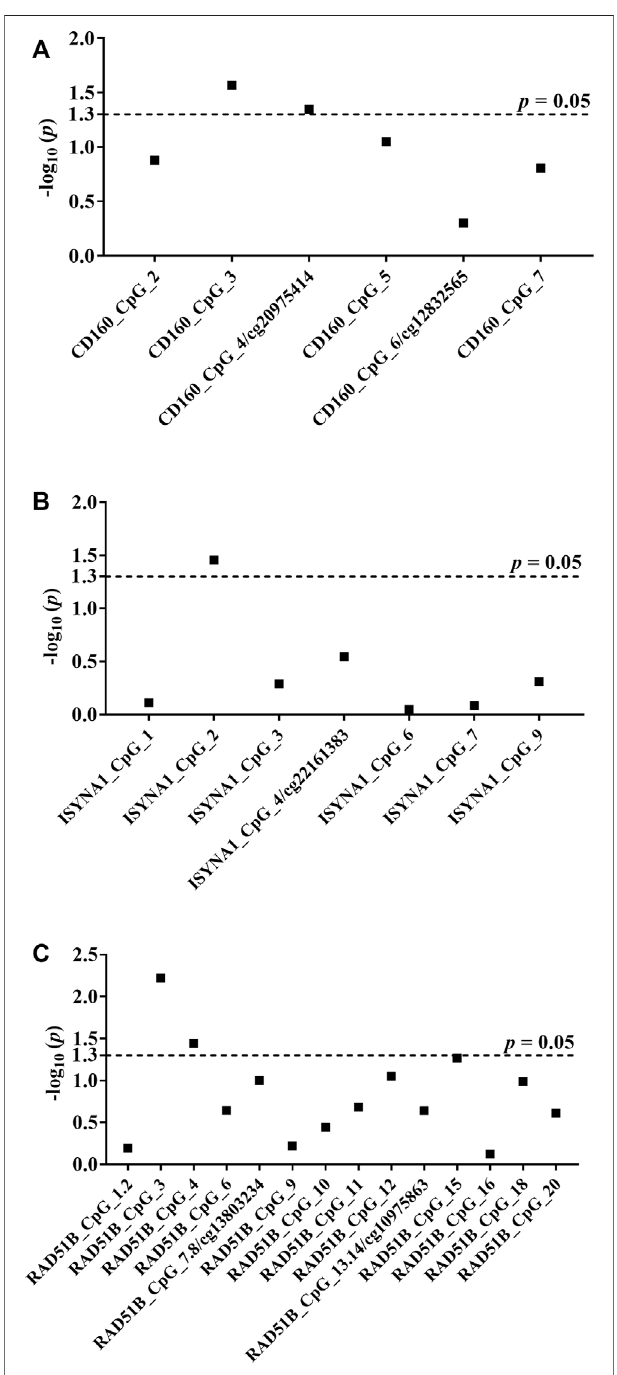
FIGURE 2 | Association between hypomethylation of CD160 , ISYNA1 , and RAD51B and sporadic BC combining validation I and validation II. The p values of all measureable CpG loci were calculated by logistic regression adjusted for age and different batches for the measurements, and all the p values were transformed by − log 10 . The dotted lines indicate the thresholds of p values of 0.05. (A) Association between hypomethylation of CD160 and sporadic BC combining validation I and validation II. (B) Association between hypomethylation of ISYNA1 and sporadic BC combining validation I and validation II. (C) Association between hypomethylation of RAD51B and sporadic BC combining validation I and validation II.